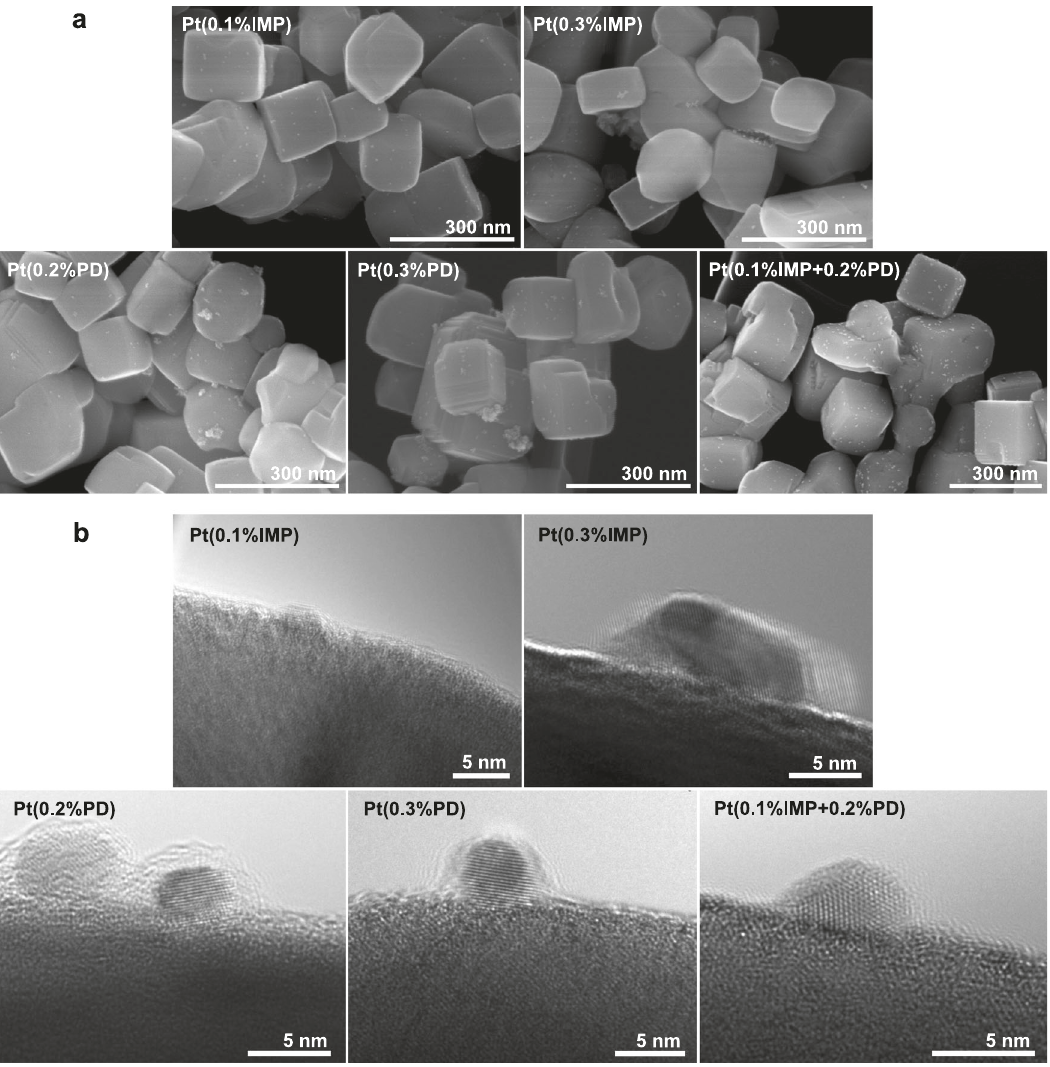
Fig. 2 Morphology and interfacial structure of Pt nanoparticles and BaTaO 2 N (RbCl) photocatalyst. a , b SEM images ( a ) and HRTEM images ( b ) of Pt-modi fi ed BaTaO 2 N produced by three different methods. IMP, PD, and IMP + PD denote Pt loading by impregnation – reduction, photodeposition, and sequential deposition,